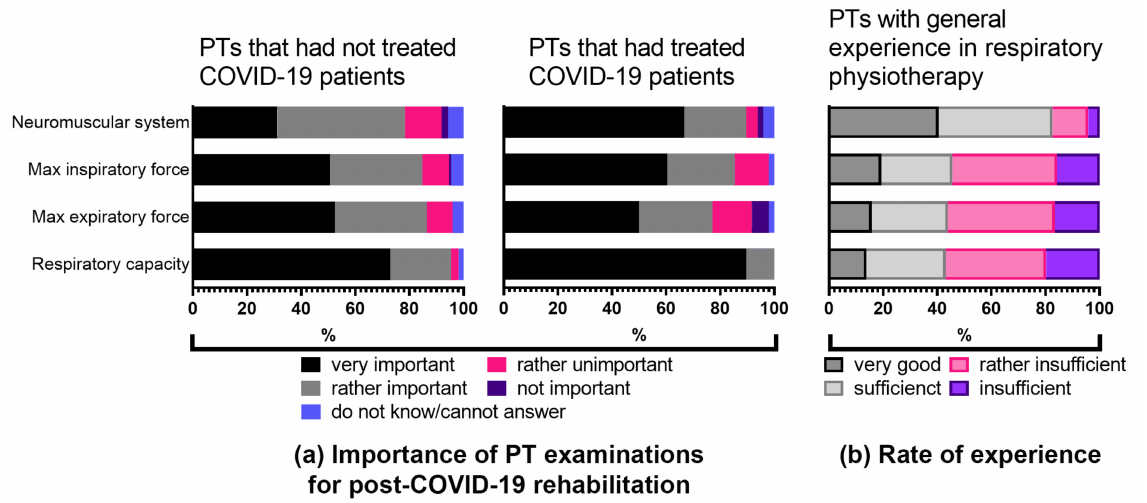
Figure 3. ( a ) Perception of physiotherapists regarding the importance of specific tests for examining post-COVID-19 patients. ( b ) Assessment of experience in performing specific tests by physiotherapists with previous experience in respiratory rehabilitation. PT, physiotherapy; PTs, physiotherapists. See also Supplementary PDF